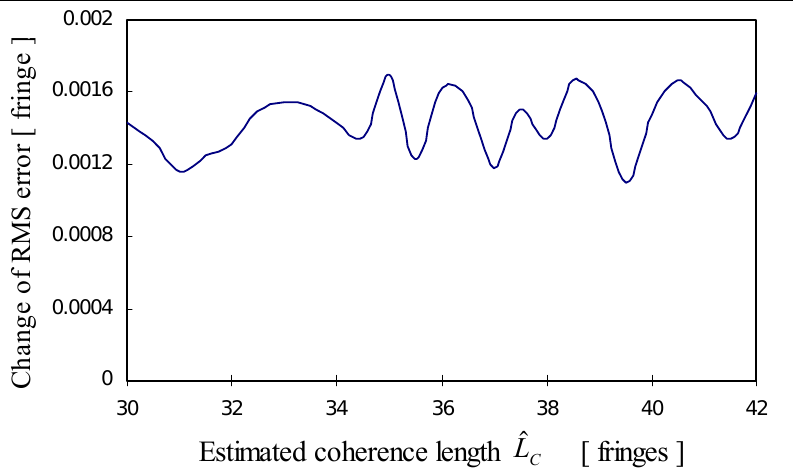
Figure 15 . Change of RMS error as a function of estimation error in light source coherence